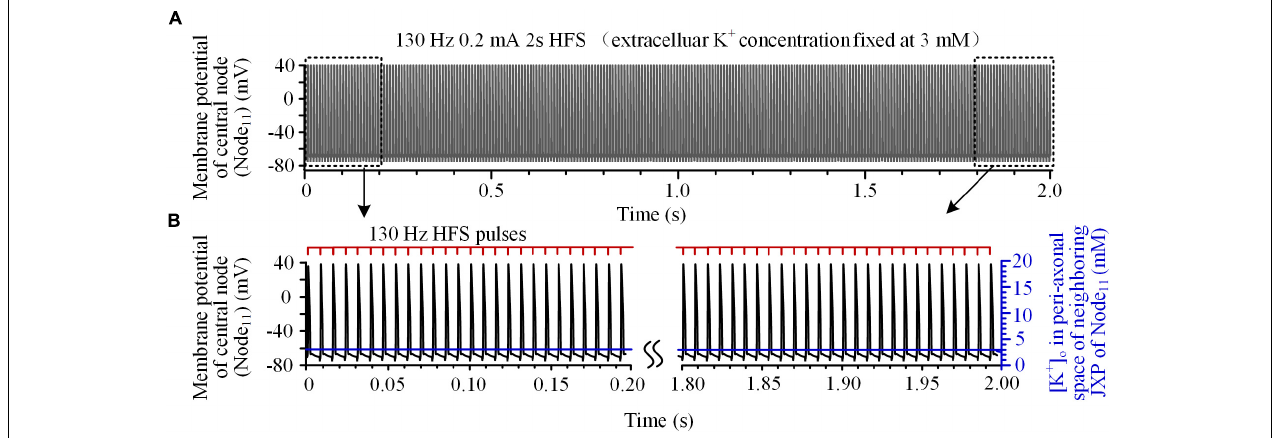
FIGURE 3 | Axonal responses during high-frequency stimulation (HFS) when the extracellular K + concentration was fixed at 3 mM: (A) Action potentials induced by 130 Hz pulses during 2-s HFS. (B) Membrane potential at Node 11 (black curves) and [K + ] o in the peri-axonal space of neighboring JXP (blue curves) during the first and last 0.2 s of the 2-s HFS shown in (A) . Every stimulation pulse induces an action